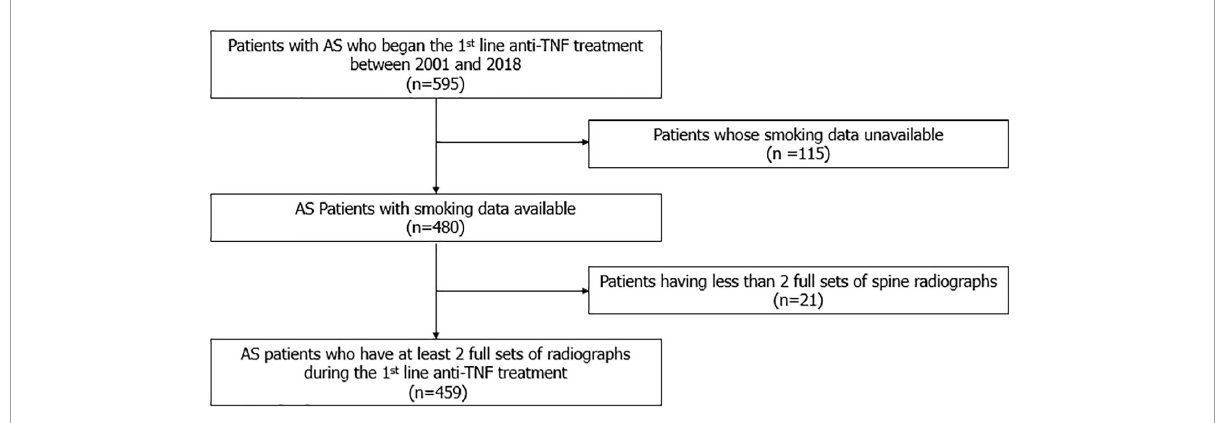
FIGURE1 Flow chart of patient